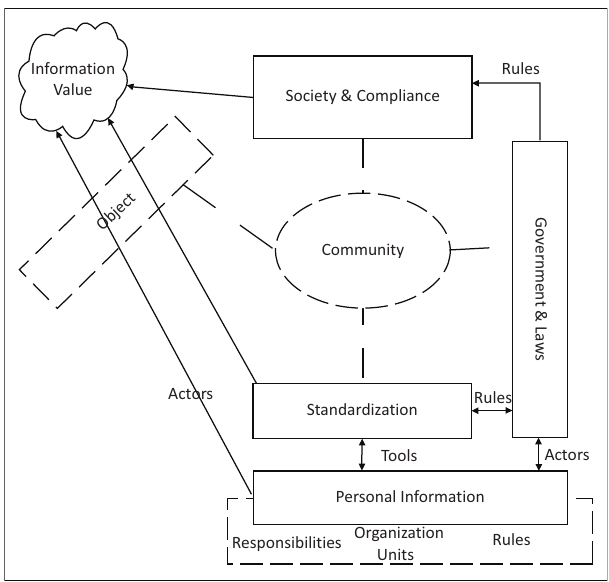
FIGURE 2: Framework for protection of